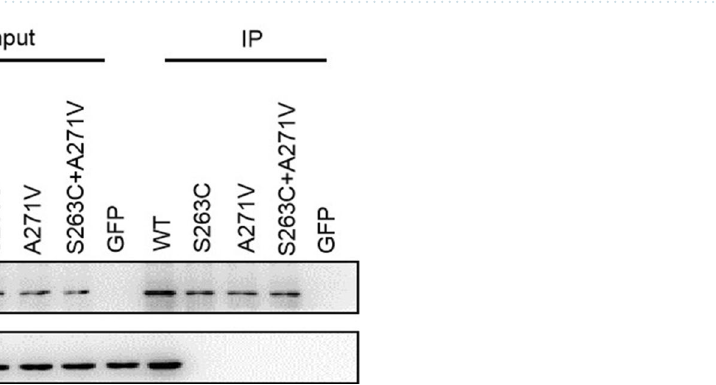
Figure 3. SpVrg4p is important for maintaining cell wall integrity under temperature stress. ( A ) WT and vas4-1 cells transformed with the wild-type vas4 + / vrg4 + gene or vector were incubated at 27 °C for 2 days. ( B ) vas4-1 cells transformed with the WT or the mutant vas4 + / vrg4 + gene were incubated at 24, 27, or 36 °C for 2 days. ( A , B ) Cells were spotted on plates containing YPD or YPD plus 100 μg/ml SDS, 1 M NaCl, 0.1% Congo red (CR) or 0.5 mg/ml calcofluor white (CFW), as indicated, in serial tenfold dilutions with the starting point indicated by OD 660 = 0.3 in log-phase and then incubated for 2 days at the indicated temperature.